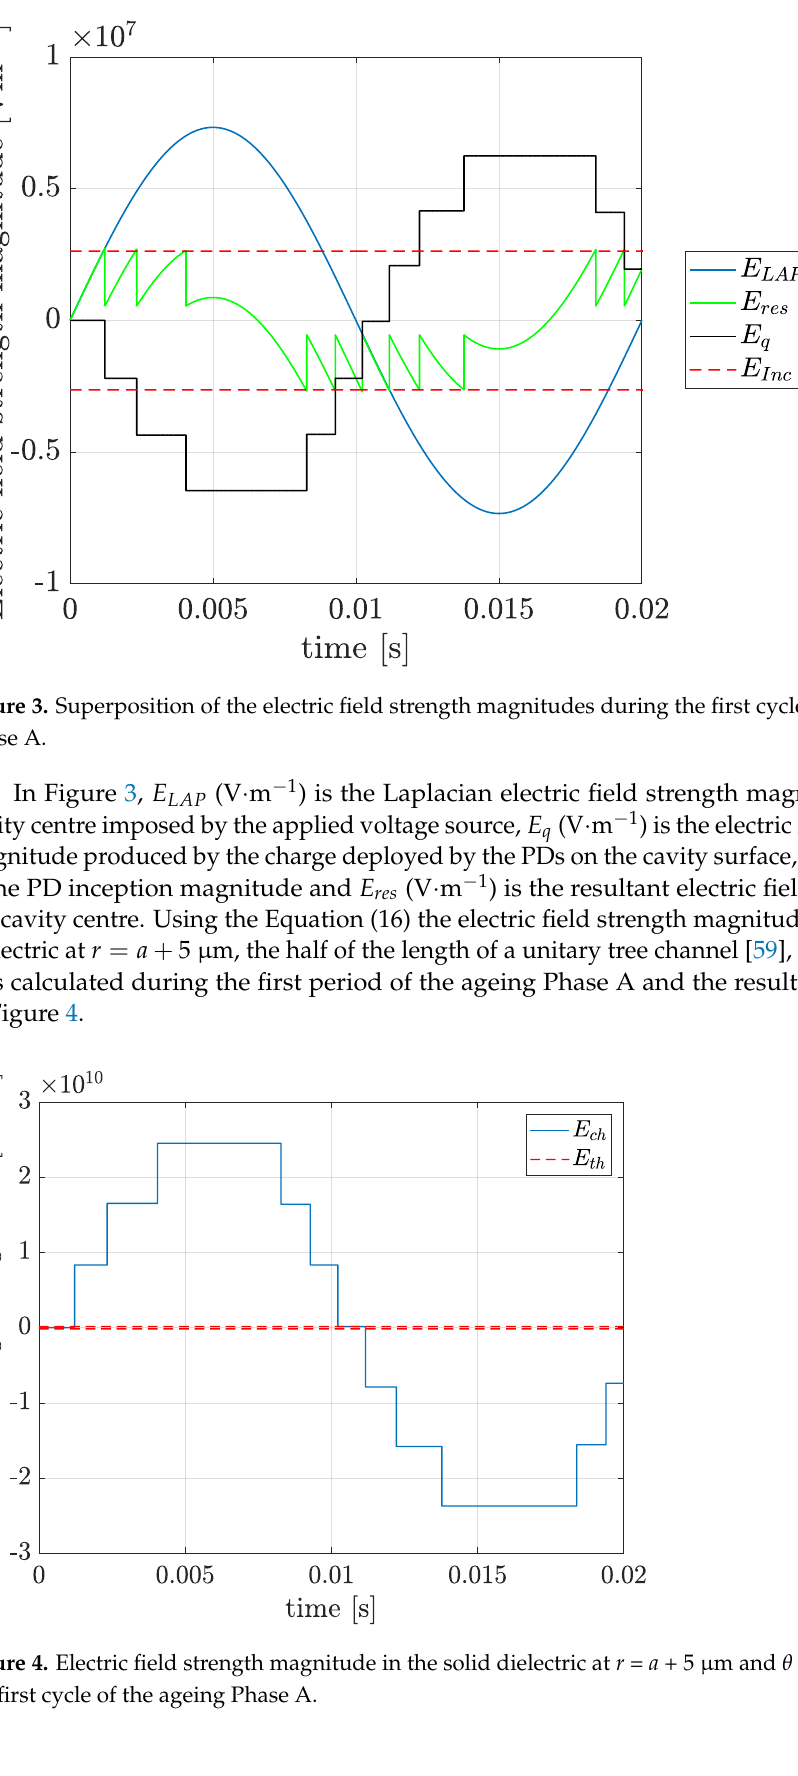
Figure 4. Electric field strength magnitude in the solid dielectric at r = a + 5 µ m and θ = 180 ◦ , during the first cycle of the ageing Phase A. E (V ‧ m⁻ 1 ) is the electric field strength magnitude in the solid dielectric In Figure 4 ch E (V ‧ m⁻ 1 ) is threshold magnitude for incepting avalanches in the microscopic chan- and th